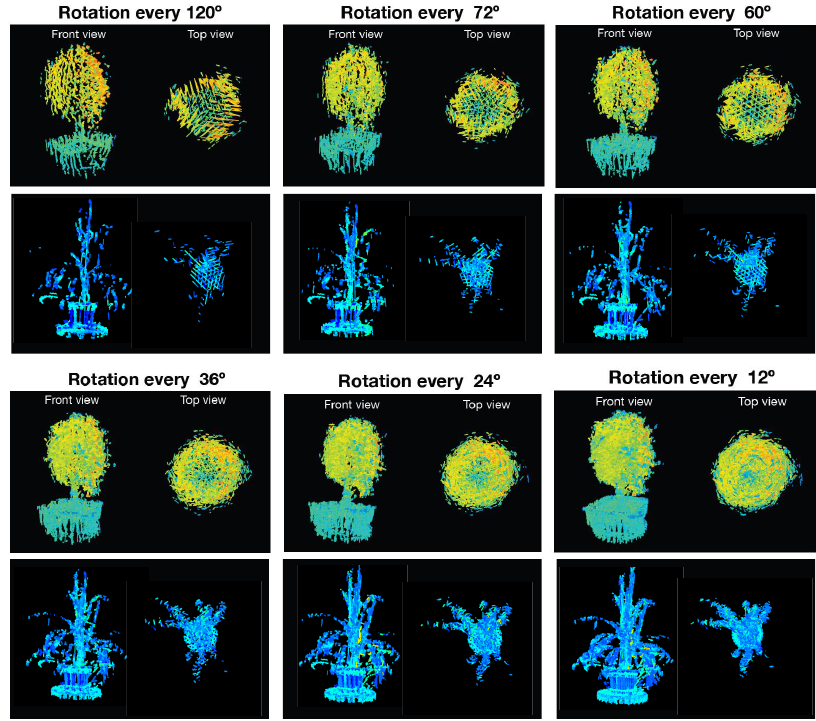
Figure 18. 4D phenotyping models captured at different rotation angles. time. For that purpose, an experiment was conducted in which the Guaiacum plant was 411 scanned during different moments of a single day, to observe how the NDVI vegetative 412 index average behaved over time in this plant. As a result, the graph of the average 413 NDVI of the Guaiacum plant during the day is presented in Figure 19. In order to 414 perform a qualitative analysis of this behavior, Figure 20 presents the 4D phenotyping 415 models of the Guaiacum plant for three different moments in the day, in which the 416 lowest and highest values of the average NDVI were found. 417